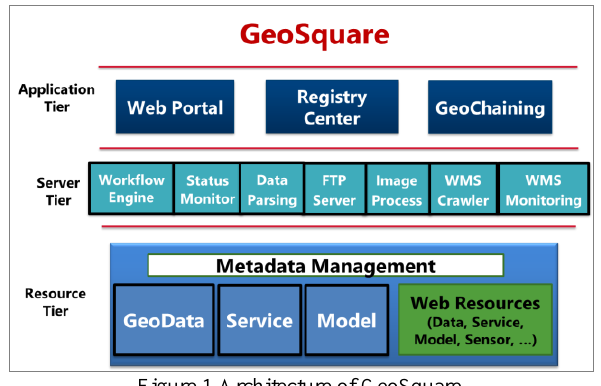
Figure 1 Architecture of